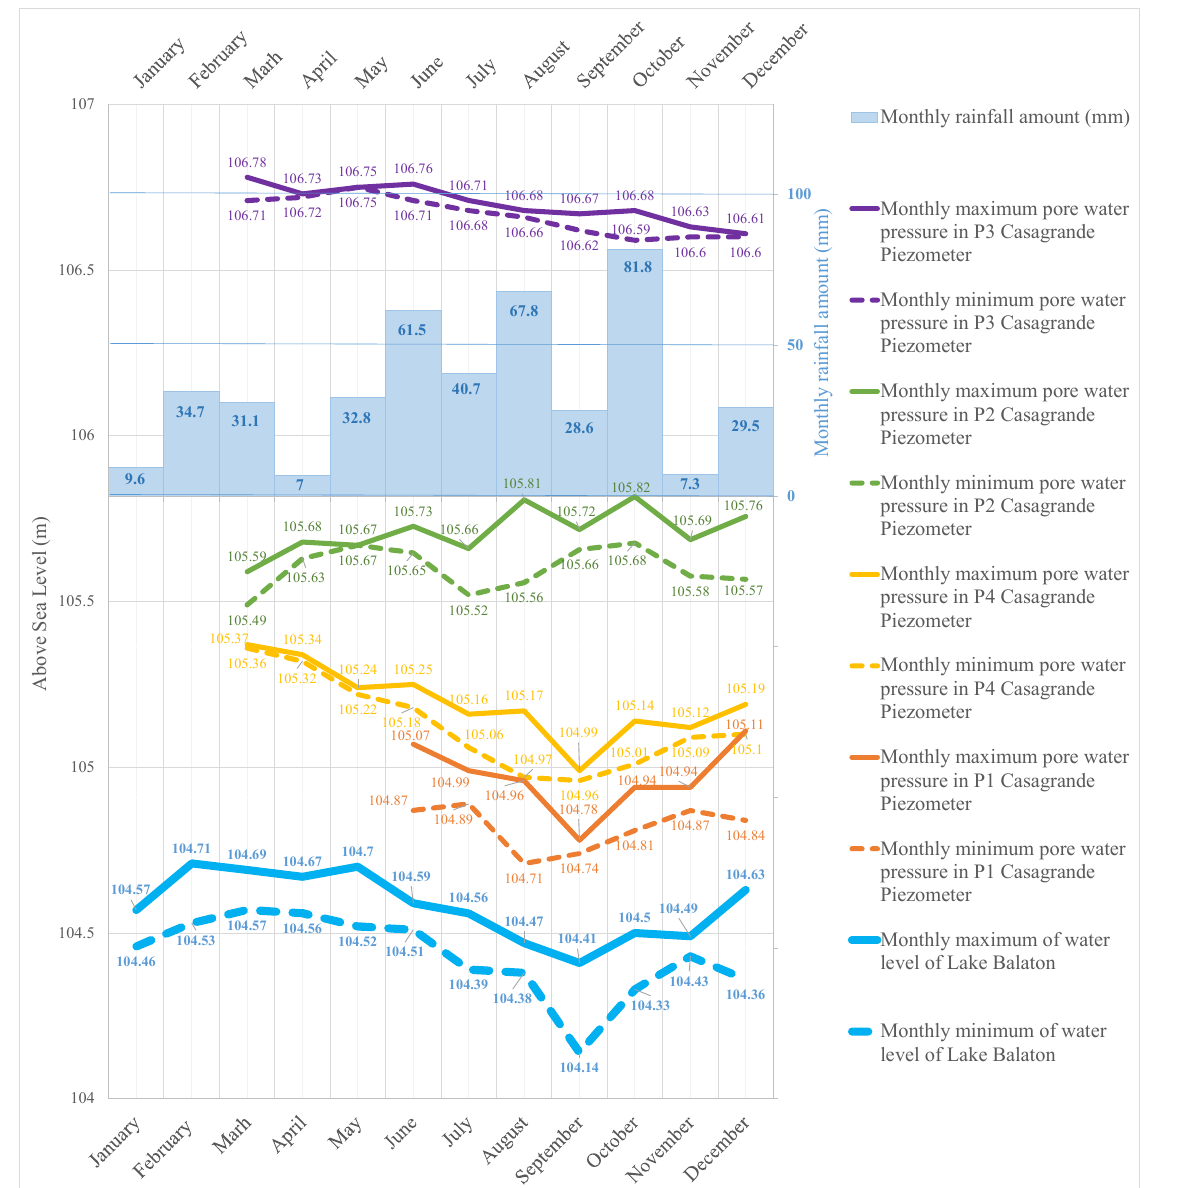
Figure 7. The development of lake-water level, pore water pressures and rainfall in the area during